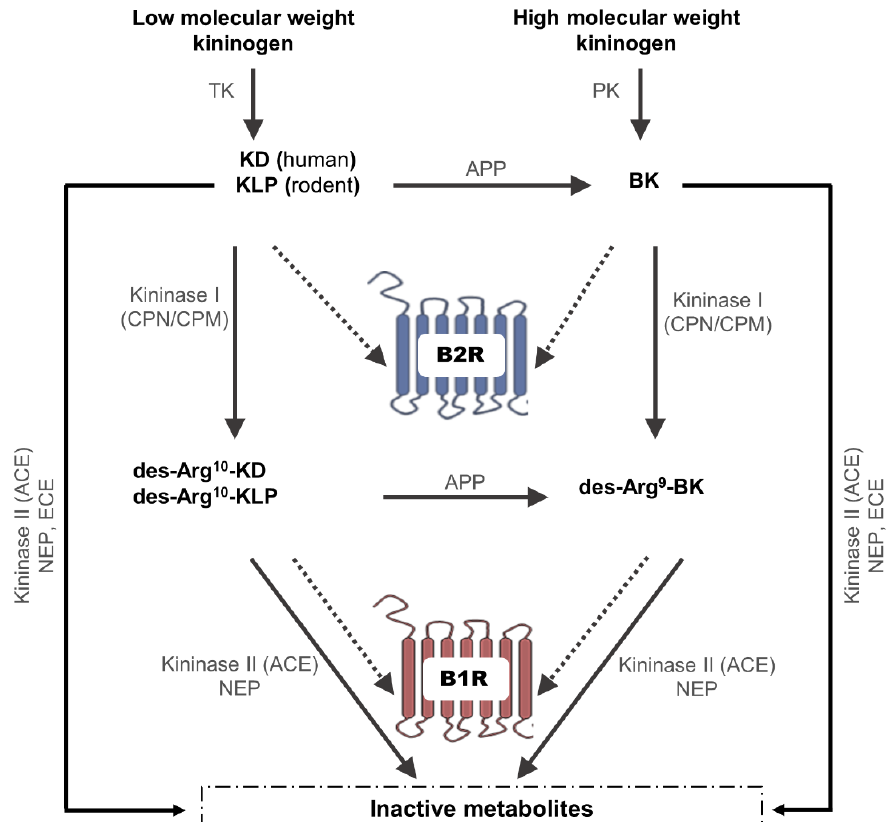
Figure 1. Biosynthesis and metabolism of kinins. Low- and high-molecular-weight kininogens are cleaved by tissue kallikrein and plasma kallikrein, respectively, into kallidin (in humans) and kallidin-like peptide (in rodents) [5,6], and bradykinin. Bradykinin, kallidin, and kallidin-like peptide are then either converted by the action of kininase I to des-Arg 9 -bradykinin, des-Arg 10 -kallidin, and des-Arg 10 -kallidin-like peptide, respectively, or inactivated by kininase II, neutral endopeptidase 24.11 (neprilysin, NEP), and the endothelin-converting enzyme [4,7–11]. ACE, angiotensin-1-converting enzyme (also known as kininase II); APP, aminopeptidase P; B1R, bradykinin type 1 receptor; B2R, bradykinin type 2 receptor; BK, bradykinin; ECE, endothelin-converting enzyme; KD, kallidin; KLP, kallidin-like peptide, which is Arg(1)-kallidin (Arg(0)-bradykinin); NEP, neutral endopeptidase; PK, plasma kallikrein; TK, tissue kallikrein.